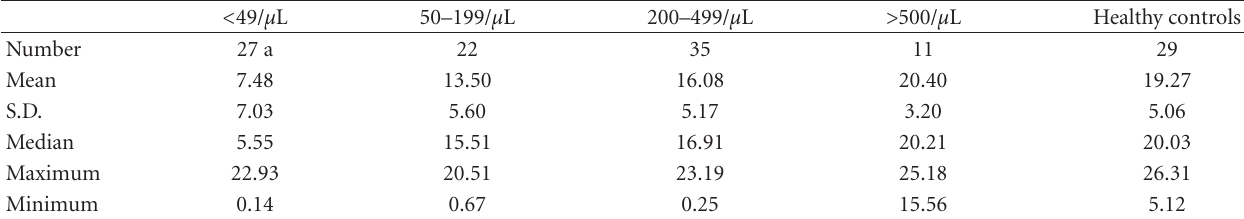
Table 4: Interferon-gamma responses for mitogen according to CD4 + T cell count category in HIV-infected patients without active TB disease and healthy